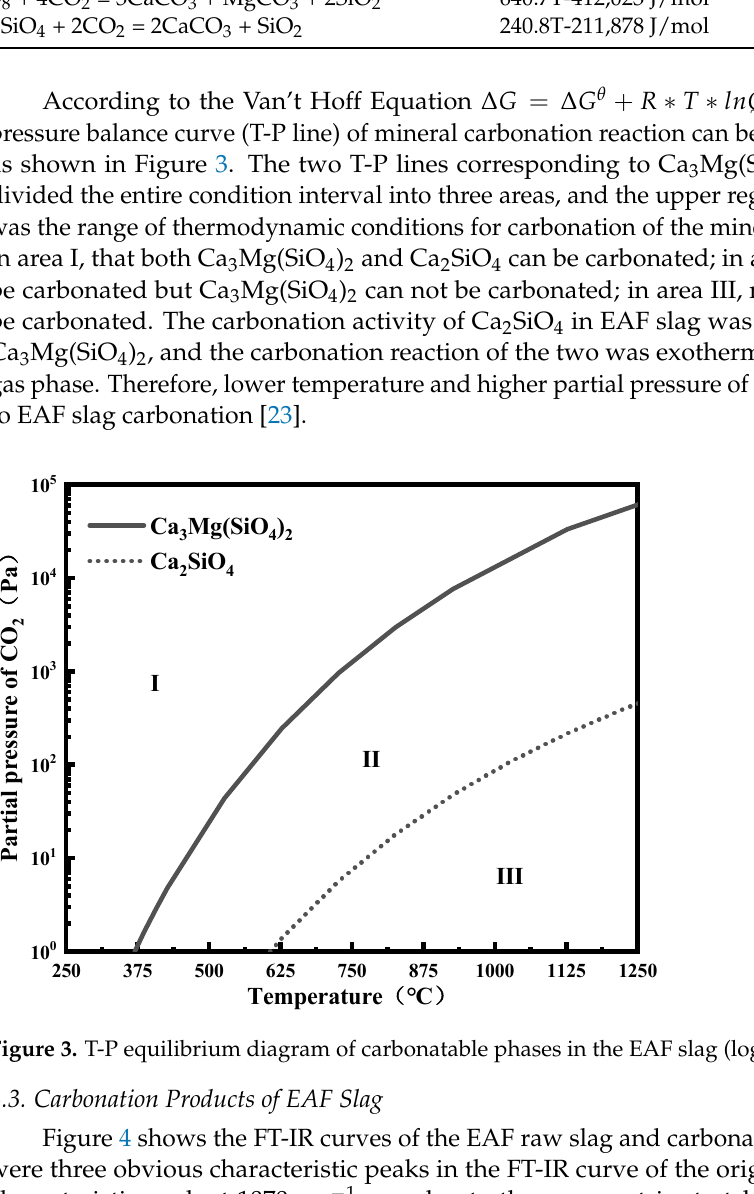
Table 2. Carbonation reaction equations of carbonatable phases in the EAF slag. Mineral Phase Carbonation Reaction Equation